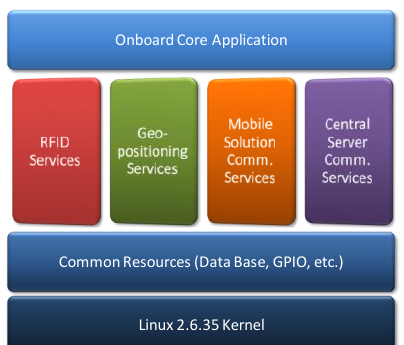
Figure 10. Middleware main modules. Onboard Core Application